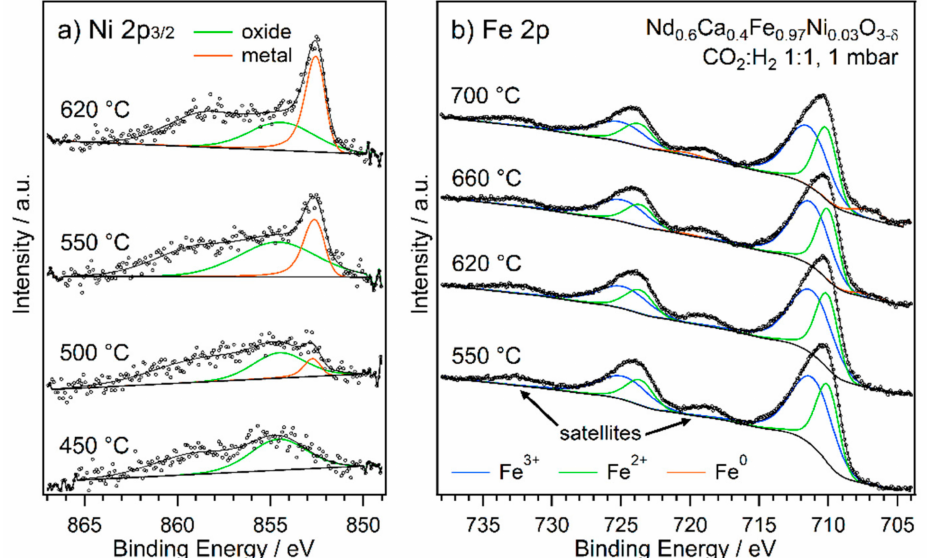
Figure 8. NAP-XPS spectra of the ( a ) Ni 2p and ( b ) Fe 2p regions of Nd 0.6 Ca 0.4 Fe 0.97 Ni 0.03 O 3- δ in rWGS atmosphere with a CO 2 to H 2 ratio of 1:1 at increasing temperatures. While a metallic component starts to evolve for Ni already at 500 ◦ C, metallic Fe is only visible from 660 ◦ C on. For both elements, the metallic contribution increases with higher temperatures. Overlapping Auger peaks and satellites have been omitted for